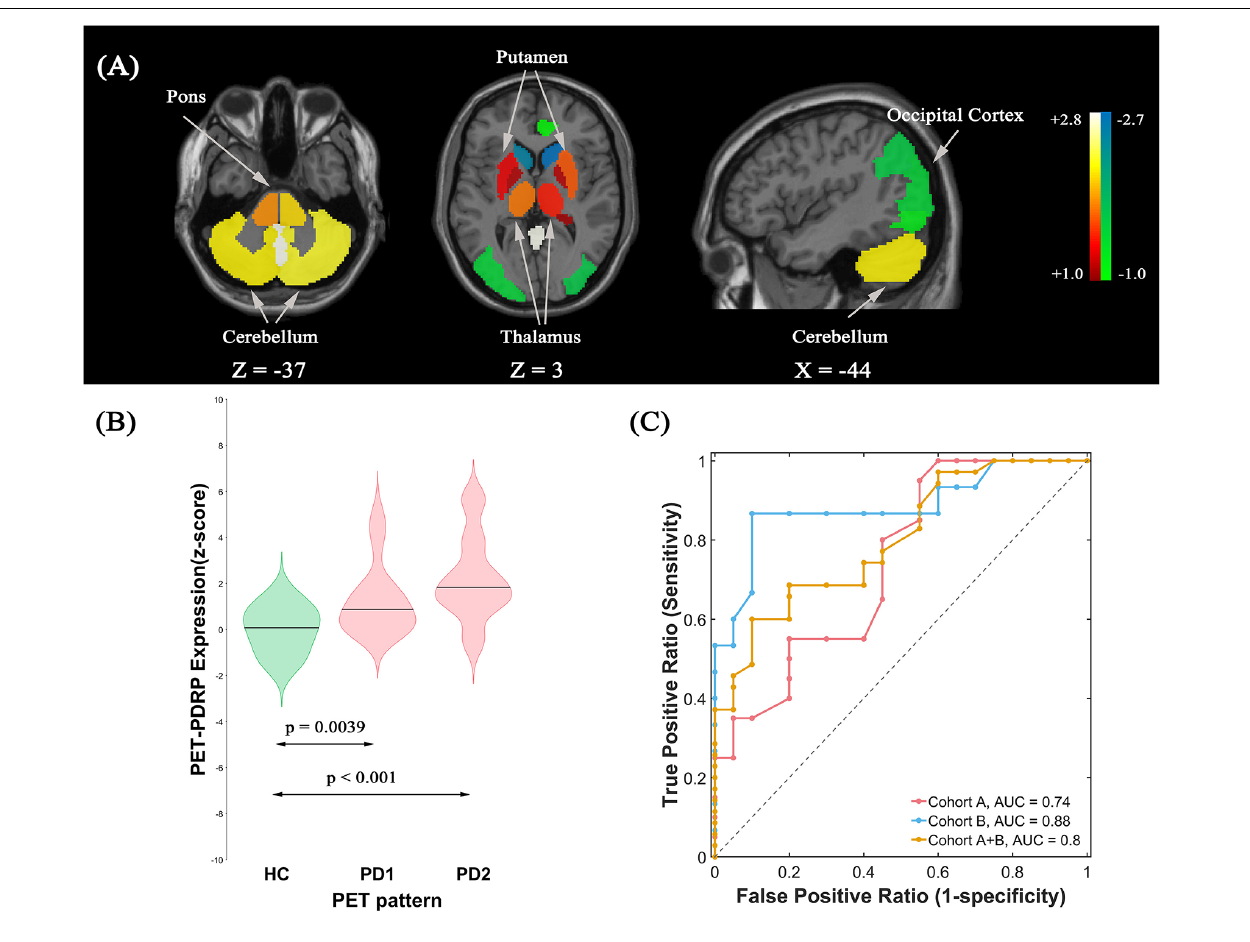
FIGURE 2 | (A) Metabolic Parkinson’s disease-related pattern (PET-PDRP) identified by Scaled Subprofile Modeling (SSM) multivariate analysis of 18 F-FDG PET scans from 20 (PD) patients in PD1 and 20 age- and gender-matched healthy controls. The pattern was characterized by relative increased metabolic activity in the pallidothalamic, pons, bilateral putamen, and cerebellum, associated with metabolic decreased in parietal–occipital areas. (B) Subject expressions for the PET-PDRP topography measured using violin plots in the HC, PD1, and PD2 scans (horizontal lines indicate group medians). Significant increases in pattern expression were seen in PD1 original derivation subjects and PD2 validation subjects with respect to HC control values. (C) Receiver operating characteristic (ROC) curve for discriminating PD patients from healthy